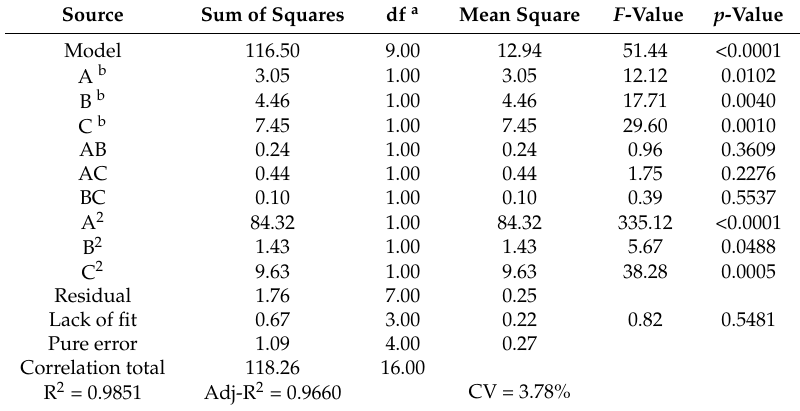
Table 2. ANOVA results for the yield of